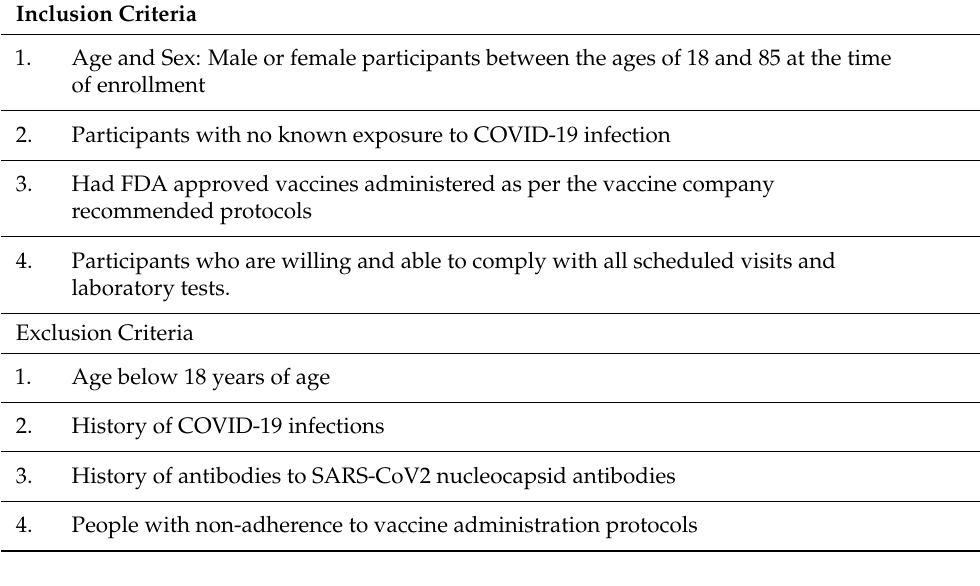
Table 1. Inclusion/Exclusion Criteria of participants enrolled in study.